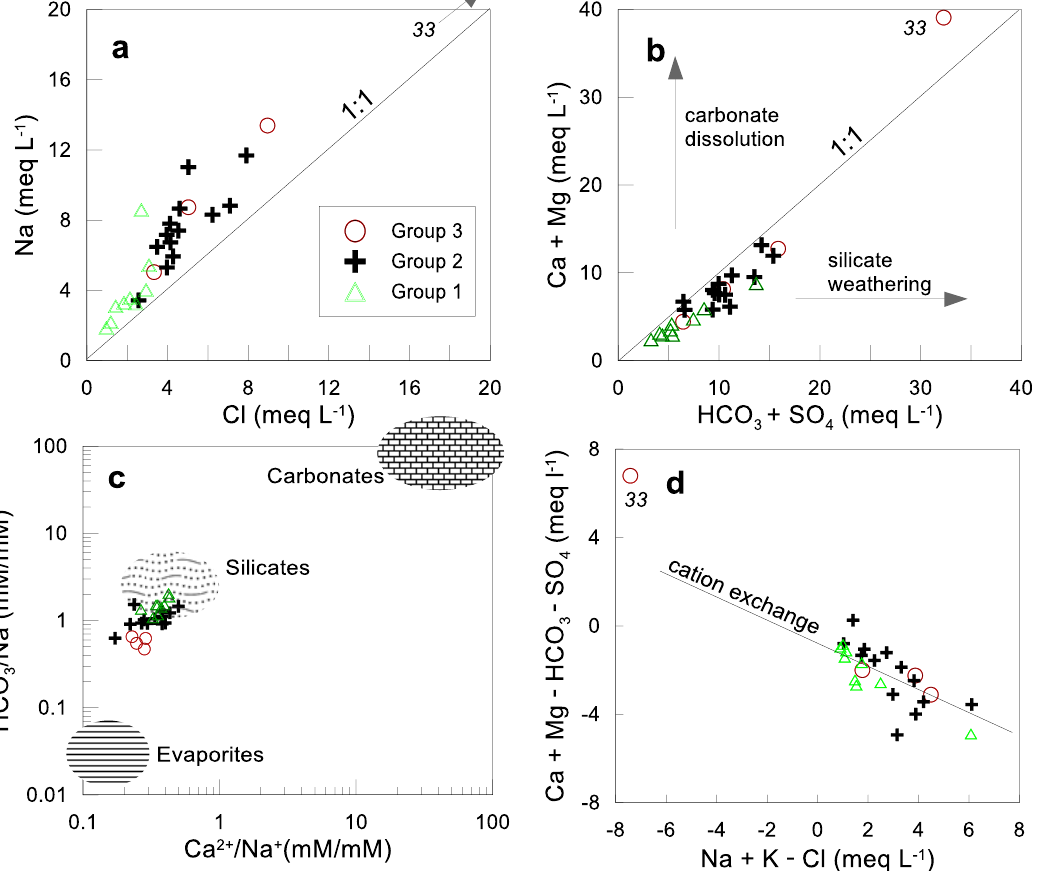
Figure 4. Scatterplots used to assess hydrogeochemical processes: ( a ) Na vs. Cl; ( b ) (HCO 3 + SO 4 ) vs. (Ca + Mg); ( c ) Ca/Na vs. HCO 3 /Na; ( d ) Na + K - Cl vs. Ca + Mg - HCO 3 - SO 4 .